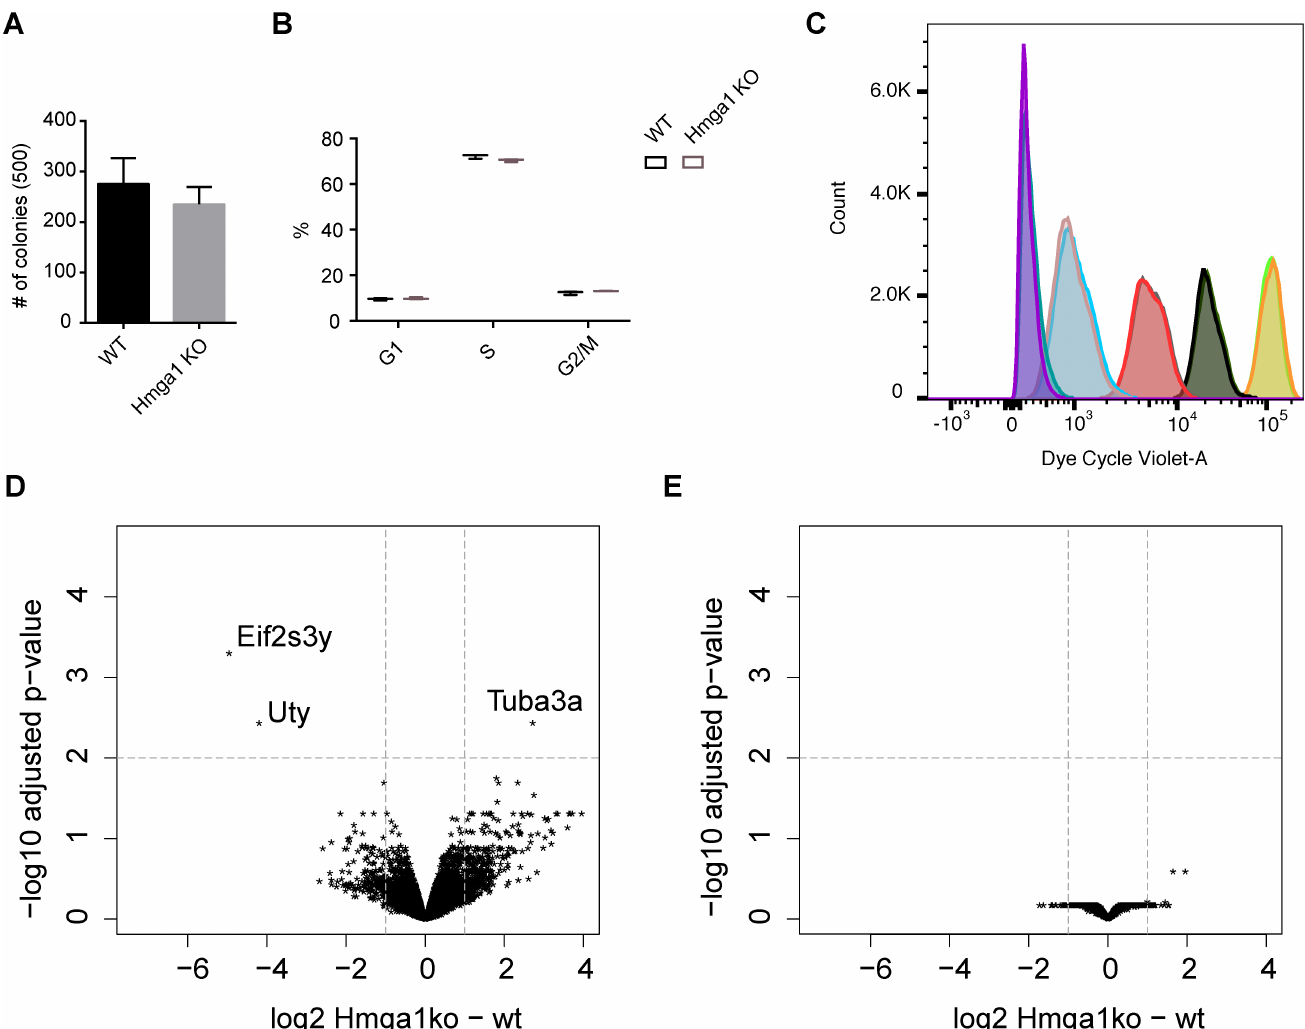
Fig 5. Hmga1 deletion in ESC does not affect transcription globally. (A) Clonogenicity assay of Hmga1 KO and parentalcell line. Triplicate biologicalreplicatecounts of pluripotentclones out of the indicatednumber of singlecells plated (in brackets). No significantchange is observed (one- way ANOVA, CI 95%). (B) Two-way ANOVA analysisof ESC cell cycle distribution data (n = 3) excludean overall difference betweenWT and Hmga1 KO samples. Only in S phase a barelysignificantdifference can be seen (adj. p-value = 0.0107). For details, see Materials and methods.Y-axis denotes percentageof cells within a gate. (C) Cell proliferation data of a WT and Hmga1 KO sample duringa 4-day time course. The distributionof actively replicatingcells in the WT and Hmga1 KO samplesare superimposable at any given time point. For colour reference and detailsrefer to S10C Fig and Materialsand methods. (D) Transcriptomic comparisonof Hmga1 KO vs. parentalcell line at the genelevel. Gene names are indicatedif the gene is significantly differentially expressed(adjustedp-value < 0.01 and absolutefold-change of at least 2). (E) Transcriptomic comparisonof Hmga1 KO vs. parentalcell line at repetitive regions of the genomeas definedby RepeatMasker, excludingrepeats lying on the same or opposite strand of annotated transcripts (Materialsand methods). Repeat elementsshow no significantchanges(adjustedp-value < 0.01 and absolutefold-changeof at least 2). Quantification was performed on the level of RepeatMasker repeat